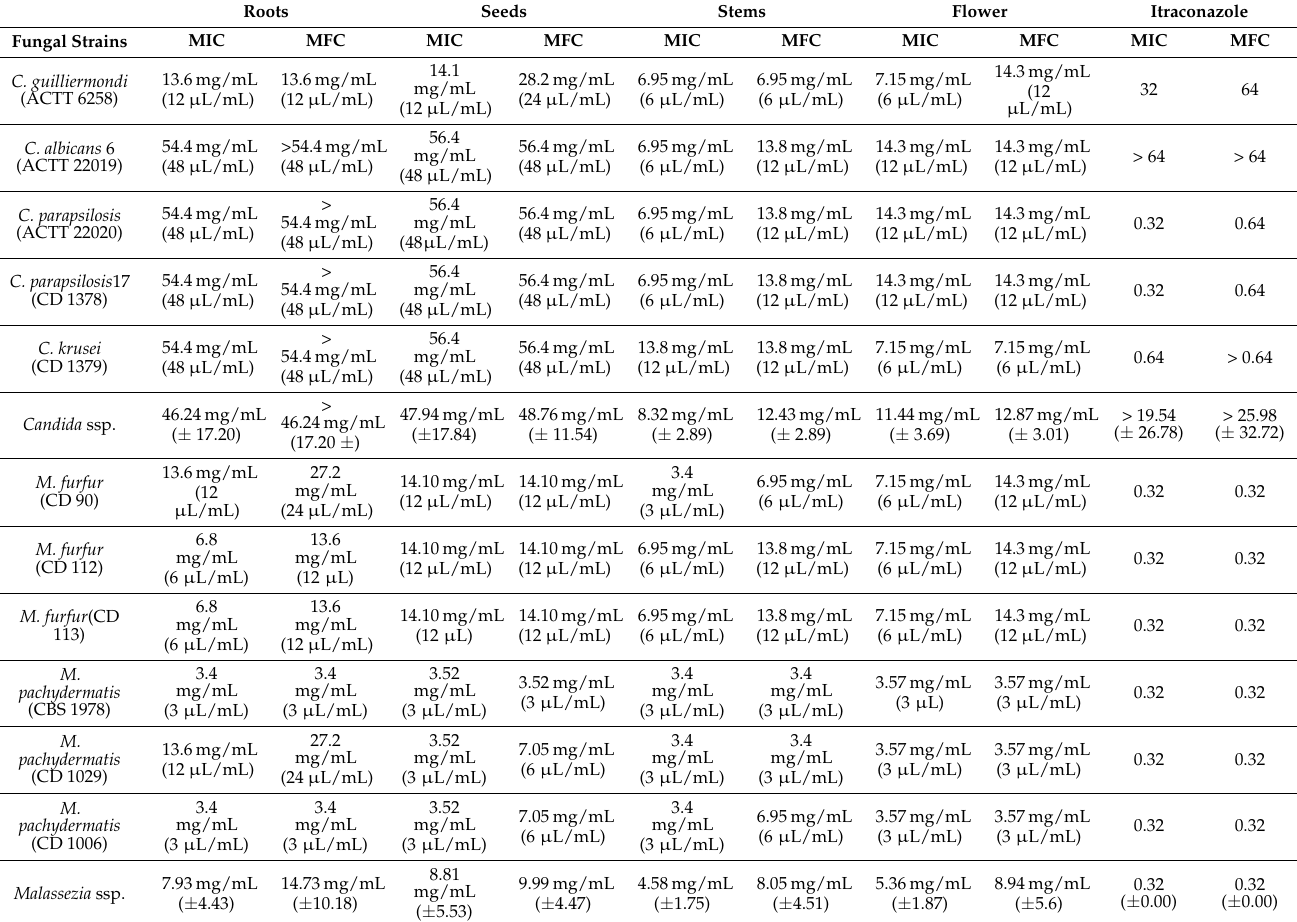
Table 4. Minimum inhibitory concentration (MIC) and minimum fungicidal concentration (MFC) ( µ g/mL) of D . triradiata EOS compared to Itraconazole ( µ g/mL) as a positive control. Roots Seeds Stems Flower